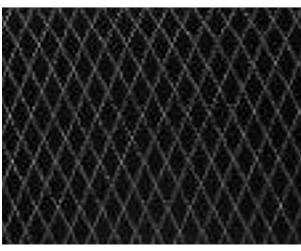
Figure 2. Textile electrode used to sense biological signals such as electrocardiography [43].